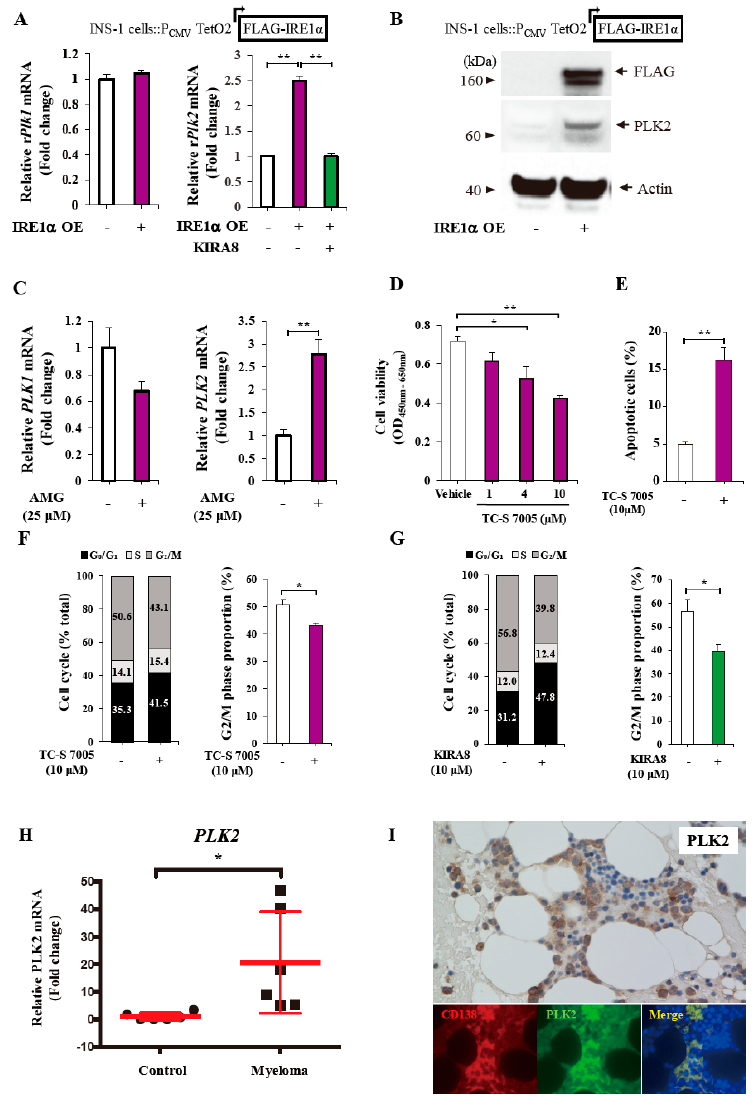
Figure 6. PLK2 expression was IRE1 α -dependent and its inhibitor exhibited anti-myeloma effects in IM-9 cells. PLK2 protein and mRNA were expressed strongly in patients with NDMM. ( A , B ) Quantitative RT-PCR of relative rat Plk1 and Plk2 mRNA levels in duplicate ( A ) and western blotting of PLK2 protein ( B ) from doxycycline (DOX)-inducible IRE1 α -overexpressing INS-1 insulinoma cells treated with vehicle (DMSO) or 0.5 µ M of KIRA8 with or without 1 µ g / mL of DOX for 24 h. ( C ) Quantitative RT-PCR of the relative PLK1 and PLK2 mRNA levels from IM-9 cells treated with 25 µ M of AMG for 24 h ( n = 3). ( D ) The cell viability in IM-9 cells treated with vehicle (DMSO) or the indicated concentrations of TC-S 7005 for 72 h ( n = 3). ( E ) Annexin V-positive / PI-negative IM-9 cells treated with vehicle (DMSO) or 10 µ M of TC-S 7005 for 72 h ( n = 3). ( F , G ) The % components of cell-cycle phases and % cells in the G 2 / M phase in IM-9 cells treated with vehicle (DMSO) and 10 µ M of TC-S 7005 for 72 h ( F ) or 10 µ M of KIRA8 ( G ) for 24 h. For these experiments, four independent biological samples were used. ( H ) Quantitative RT-PCR of relative PLK2 mRNA levels in BM samples of control subjects ( n = 6) and patients with NDMM who attained a complete response receiving bortezomib-based treatment and high-dose melphalan ( n = 6). ( I ) The expression of PLK2 protein in the BM clot specimen of a patient with NDDM was confirmed by immunohistochemical analysis with anti-PLK2 antibodies (magnification, × 200). The rabbit immunoglobulin G control was negative (data not shown). Immunofluorescence at higher magnification illustrates the expression of the PLK2 protein (green) in CD138 + myeloma cells (red). DAPI (4 (cid:48) ,6-diamidino-2-phenylindole; blue) was used as a nuclear counterstain. The data shown are the mean ± SEM. *, p < 0.05; **, p <